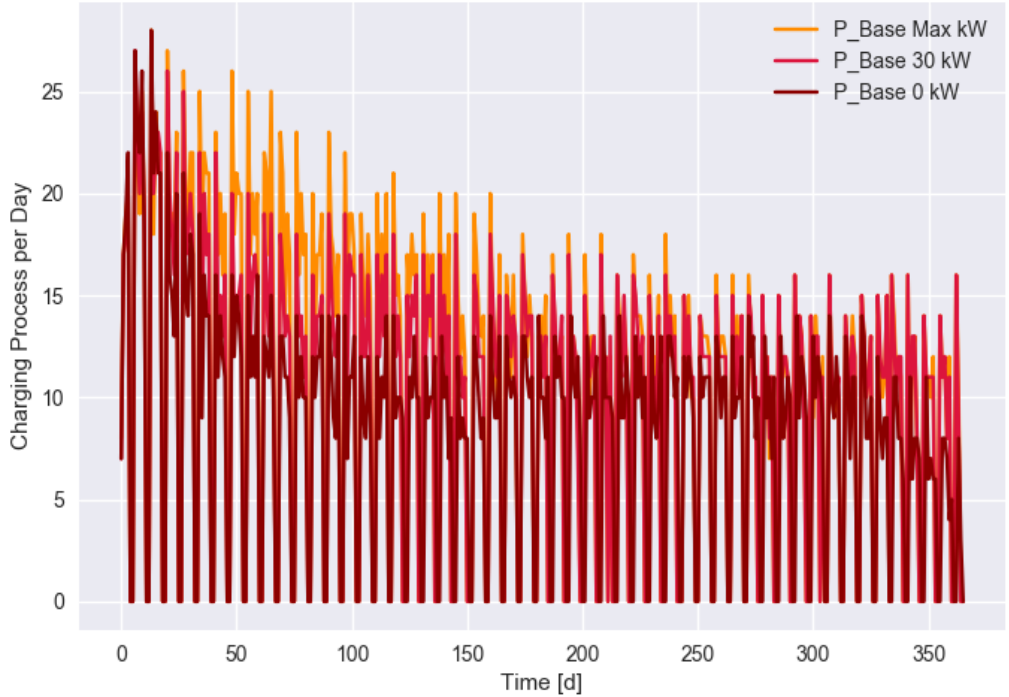
Figure 8. Number of charging processes each day in the CSI sensitive scenario for different values of P Base